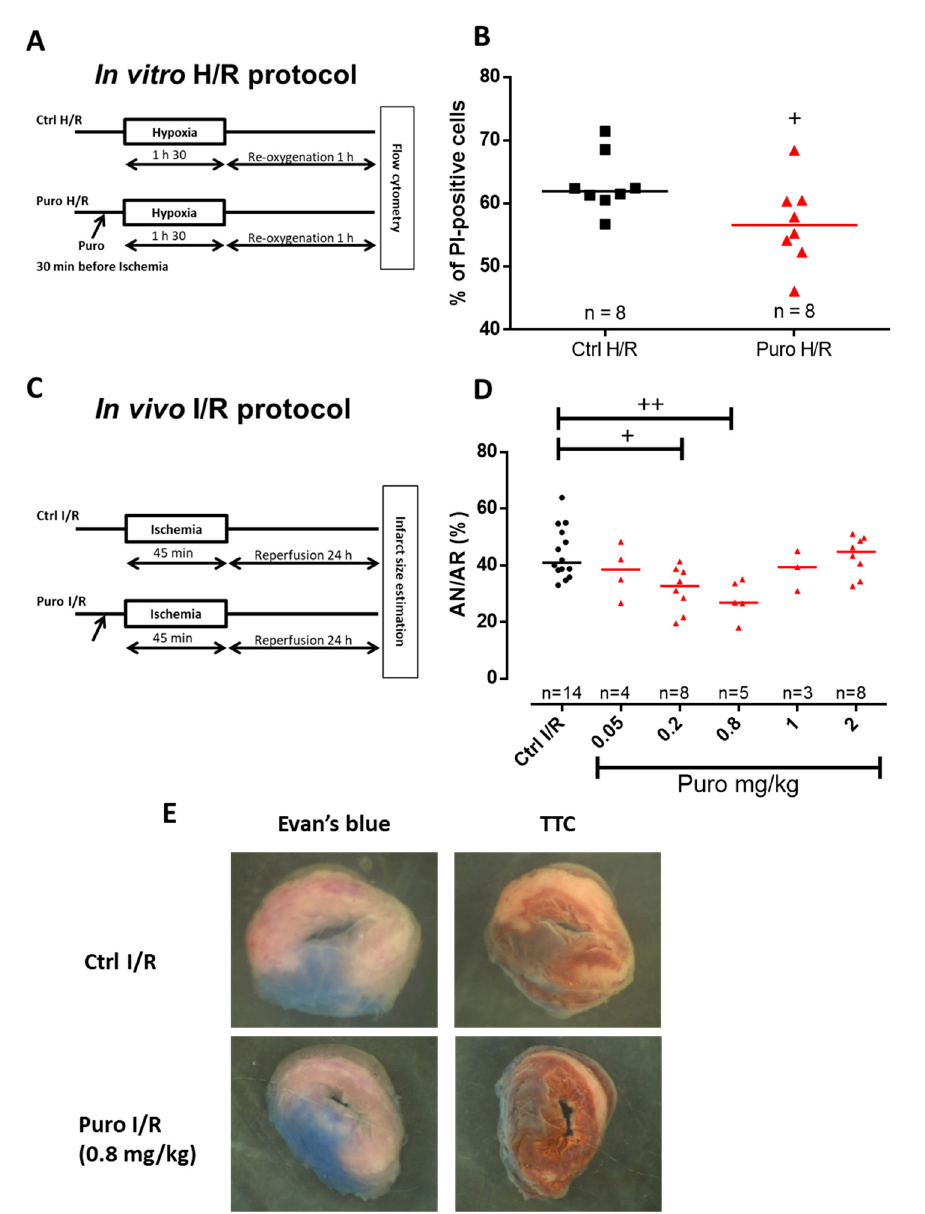
Figure 4. In vitro and in vivo CM protection by puromycin pretreatment after ischemia/reperfusion. ( A ) Experimental design representing ischemia-like hypoxia/reoxygenation (H/R) protocols achieved in isolated adult mouse CM. ( B ) Scatter plots showing mortality of CM subjected to H/R (Ctrl H/R) or CM concomitantly subjected to H/R and a 200 μ M puromycin pretreatment (puro H/R). Evaluation of CM mortality was assessed via propidium iodide (PI) staining. ( C ) Experimental design showing the I/R protocols performed in mice by a blind test comparing different concentration of puromycin. ( D ) Scatter plots representing individual I/R mouse by the percentage of necrosis area (AN) over area-at-risk (AR). n = number of animals. Statistics: + p < 0.05, ++ p < 0.01 vs. Ctrl H/R. ( E ) Representative images of Evan’s blue- and triphenyltetrazolium chloride (TTC)-stained hearts from Ctrl I/R and Puro I/R mice.